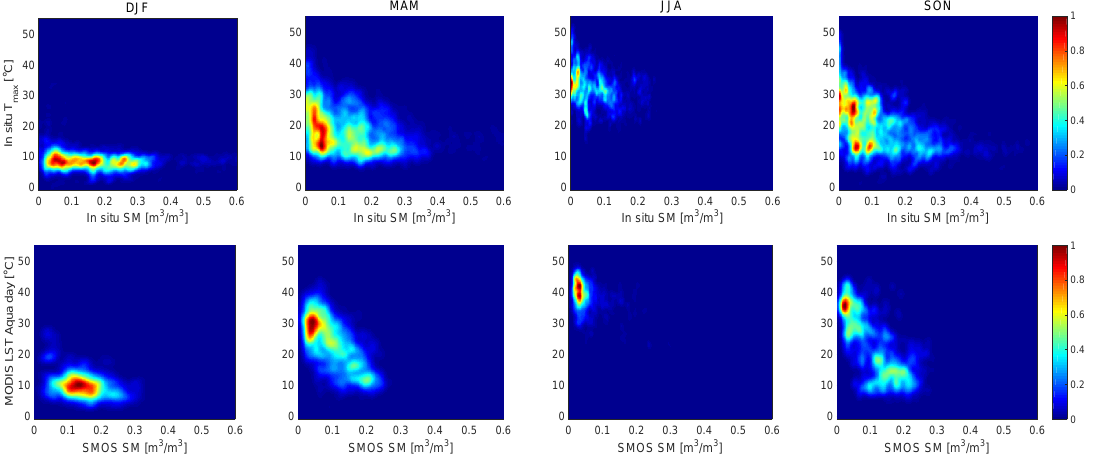
Figure 10. Normalized occurrence frequency density diagrams of in situ SM at the SMOS morning passes and T max ( top row ), and for SMOS SM at the morning passes and MODIS LST Aqua day ( bottom row ) for each season (by columns): winter (December–January–February, DJF), spring (March–April–May, MAM), summer (June–July–August, JJA) and autumn (September–October–November, SON), respectively. Similar behavior is obtained at the afternoon passes and/or using Terra day (not